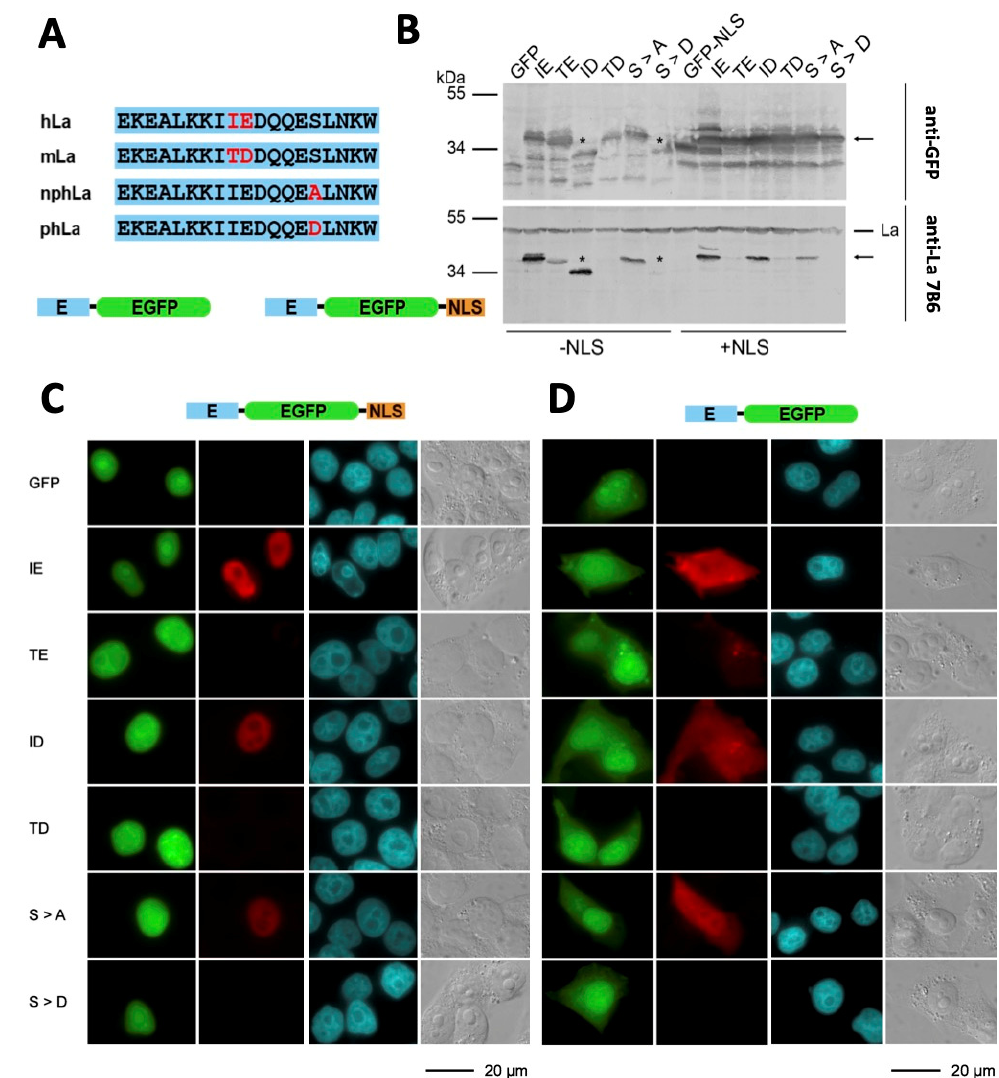
Figure 4. Posttranslational modifications in the epitope sequence of anti-La mAb 7B6. ( A ) The human (hLa) and the corresponding mouse (mLa) 7B6 epitope sequence differ with respect to the aa highlighted in red. The two aa IE in the human sequence is replaced by aa residues TD. Epitope (E) fusion proteins with an enhanced green fluorescent protein (EGFP) with (E-EGFP-NLS) or without a nuclear localization signal (NLS) (E-EGFP) were constructed. In addition, mutants were constructed in which either the aa isoleucine was replaced by threonine (TE) or the glutamate was replaced by aspartate (ID) (see B ). The human epitope sequence was reported to undergo phosphorylation in serine 325 [48]. Therefore, we replaced serine 325 with alanine (S > A) or aspartate (S > D). After transfection, total extracts were prepared and analyzed by SDS–PAGE/immunoblotting ( B ). Alternatively, cells were fixed and analyzed by IF microscopy ( C , D ). ( B ) Cellular extracts were tested for their reactivity to anti-EGFP Abs (( B ) anti-GFP, upper panel) or the anti-La mAb 7B6 (( B ) anti-La 7B6, lower panel). Cells were manipulated to express either the ( C ) E-EGFP-NLS or ( D ) E-EGFP fusion protein and were analyzed by IF microscopy. Transfected cells were identified by the green fluorescence of EGFP ( C , D ). The reactivity of the anti-La mAb 7B6 was detected in the red channel ( C , D ). Non-transfected cells were identified besides transfected cells via DNA staining with DAPI (blue channel, C , D ). * Due to a slightly different cloning procedure the linker upstream of the His-tag is smaller which explains the lower molecular weight of these fusion